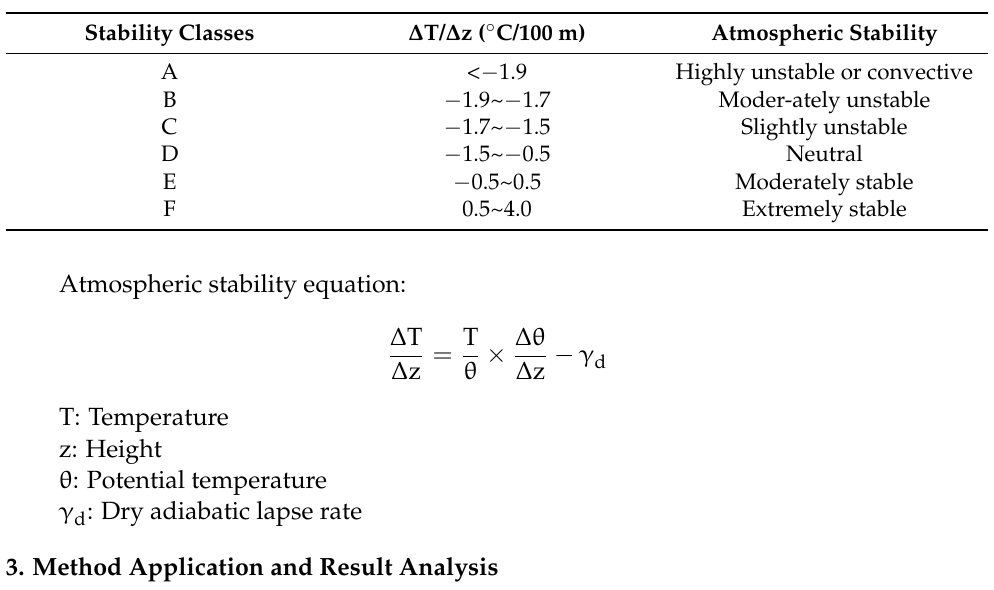
Table 1. Atmospheric stability class value